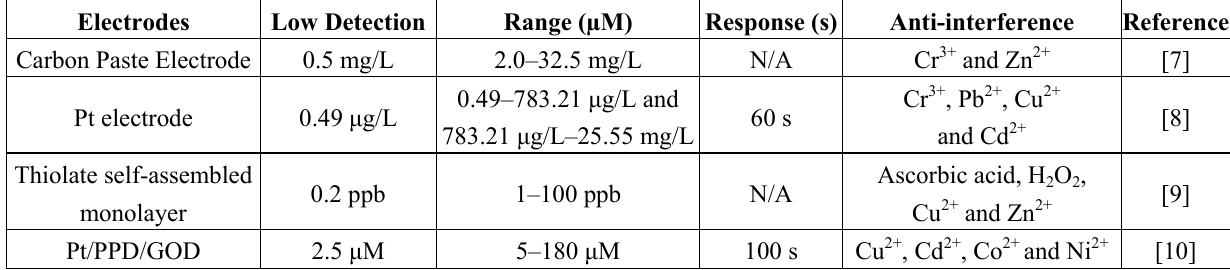
Table 1. The performance of some glucose biosensors for mercury